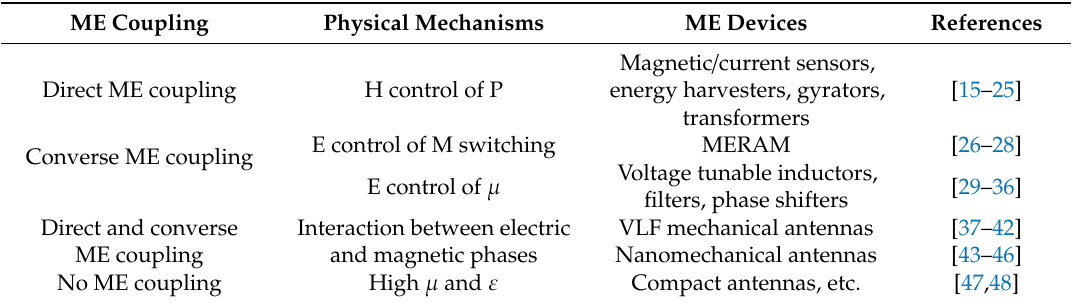
Table 1. Categories of various multiferroic devices. Adapted from